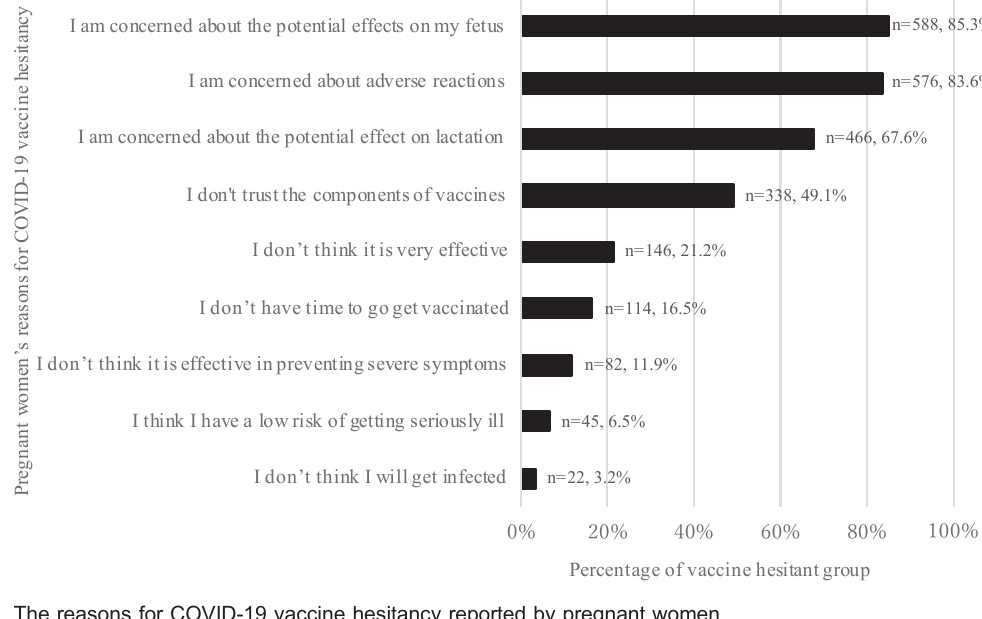
Figure 1. The reasons for COVID-19 vaccine hesitancy reported by pregnant women There were 689 participants who responded to the survey with the statement “ I want to ‘ wait and see ’ before getting the vaccine. ” The reasons participants gave for their vaccine hesitancy are listed in order of frequency. Participants could choose more than one reason; therefore, the total number of responses exceeded